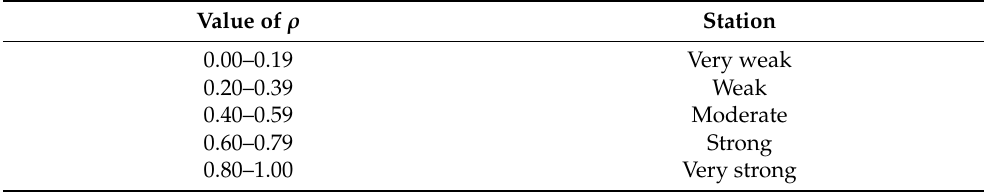
Table 2. Description of the correlation related to the value of ρ